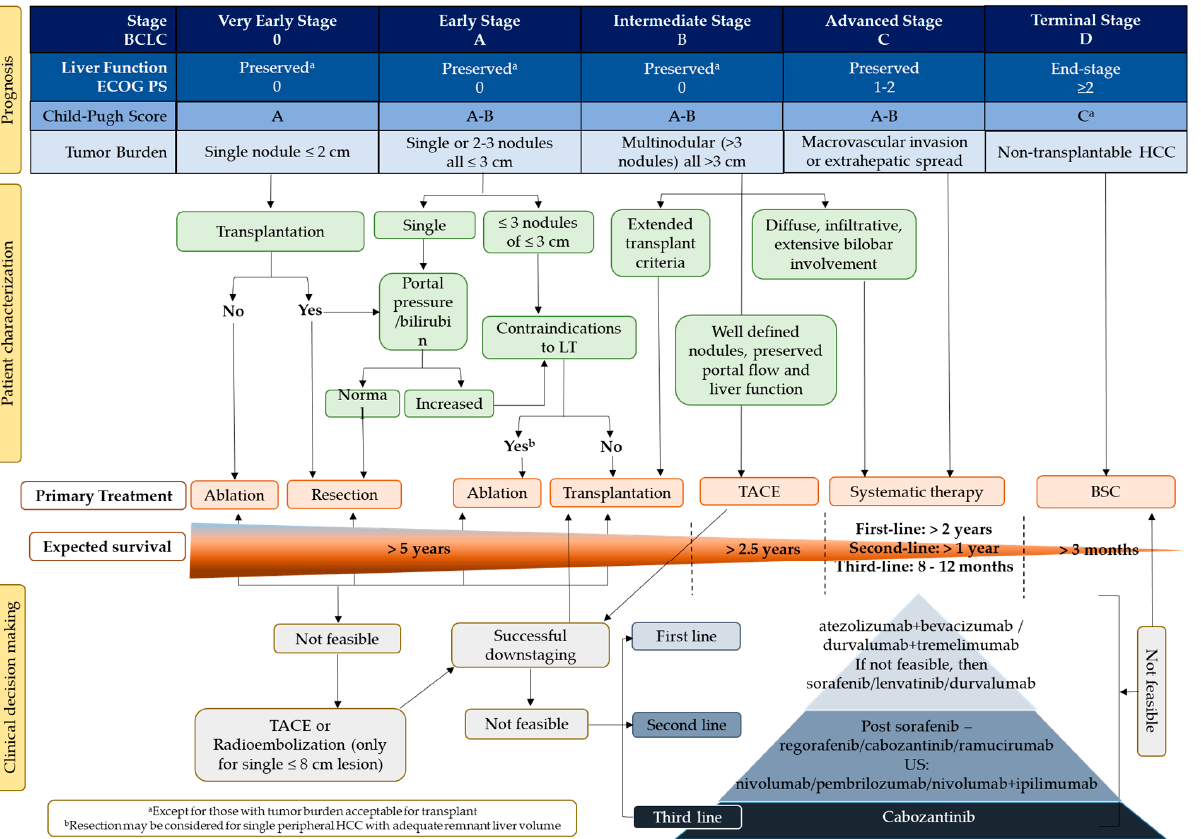
Figure 2 . HCC treatment landscape . BCLC, Barcelona Clinic Liver Cancer; BSC, best supportive care; ECOG PS, Eastern Cooperative Oncology Group performance status; HCC, hepatocellular carci- noma; LT, liver transplant; TACE, transarterial chemoembolization; US, United